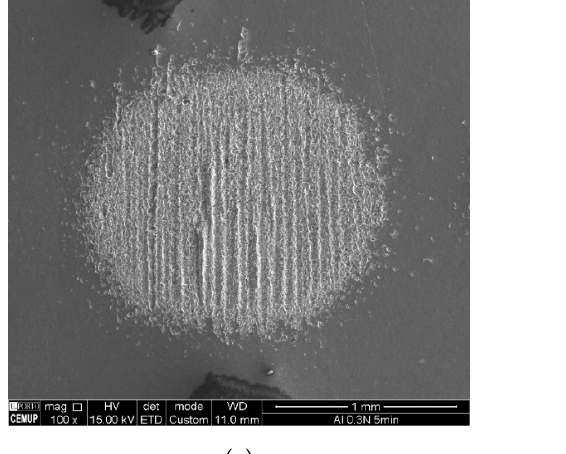
Figure 9. Wear abrasive resistance results, performed on specimens produced with 152 MPa/640 °C/2 h/high vacuum (5 × 10 − 4 Pa), ( a ) for different loads with a distance of 31.4 m and ( b ) for different distances with 0.1 N load.